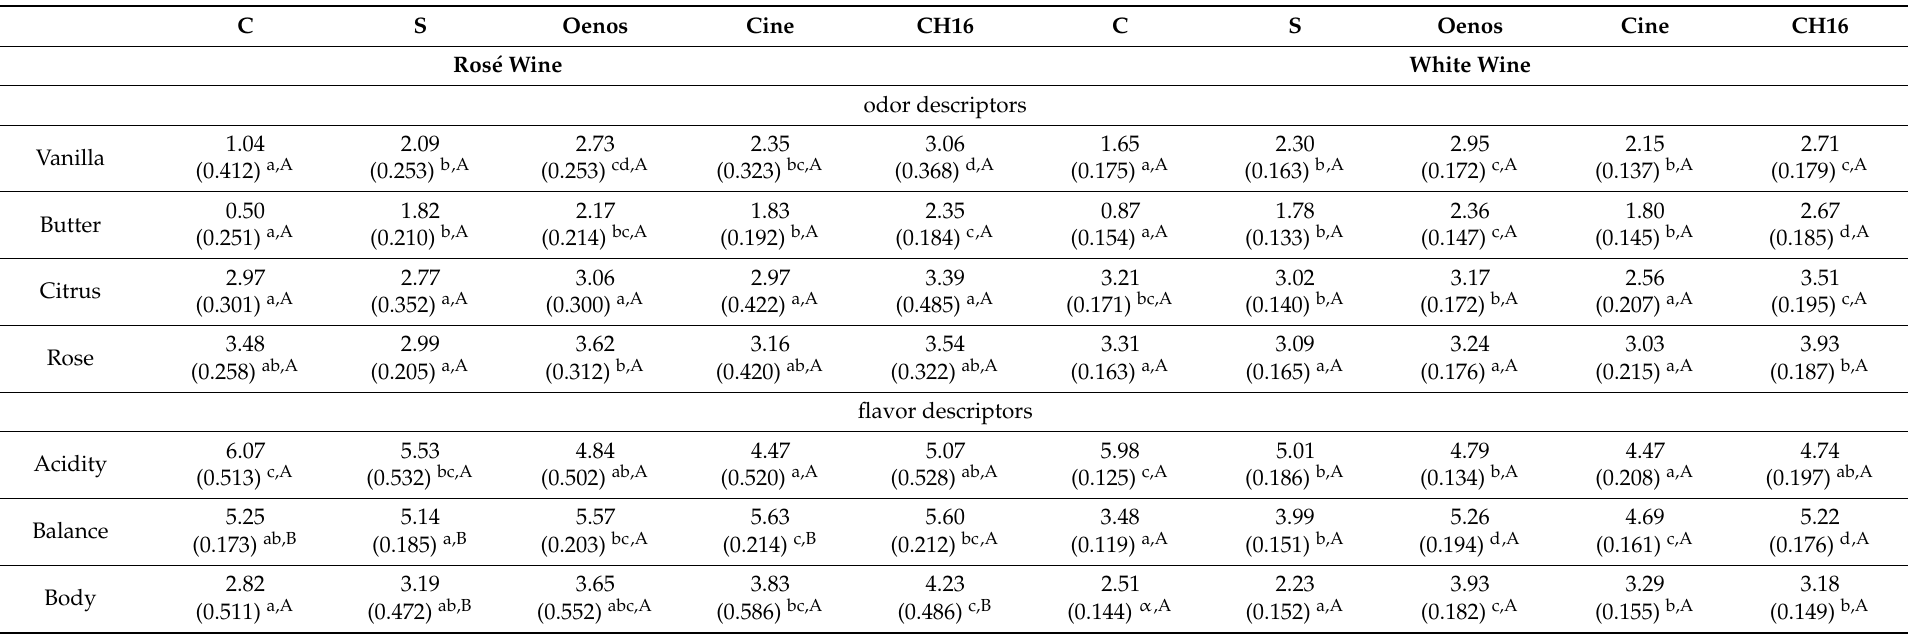
Table 3. Sensory analysis of the white and ros é